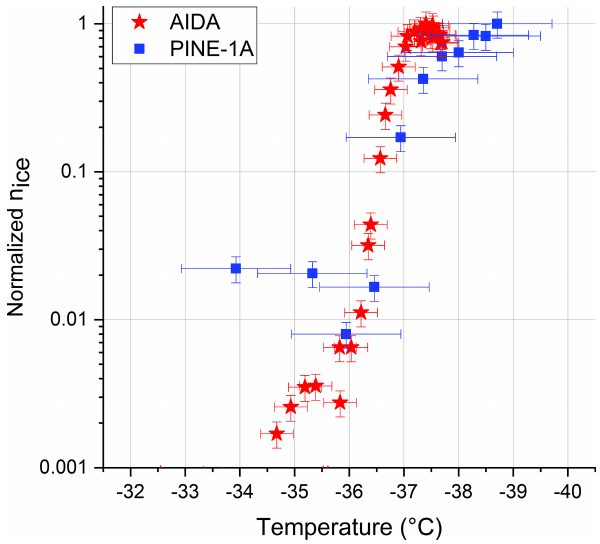
Figure 7. Homogeneous freezing of supercooled water droplets measured with PINE-1A and with AIDA during a PINE charac- terization campaign in December 2018. For this measurement, the PINE-1A was equipped with a welas 2500 OPC and sampled sul- furic acid aerosol directly from the AIDA chamber. PINE-1A was operated at a wall temperature of about − 32 . 5 ◦ C, the expansion run was done with a flow rate of 5Lmin − 1 , and reached a minimum gas temperature of − 39 ◦ C. The AIDA expansion was started at a tem- perature of about − 31 ◦ C and reached a minimum temperature of about − 38 ◦